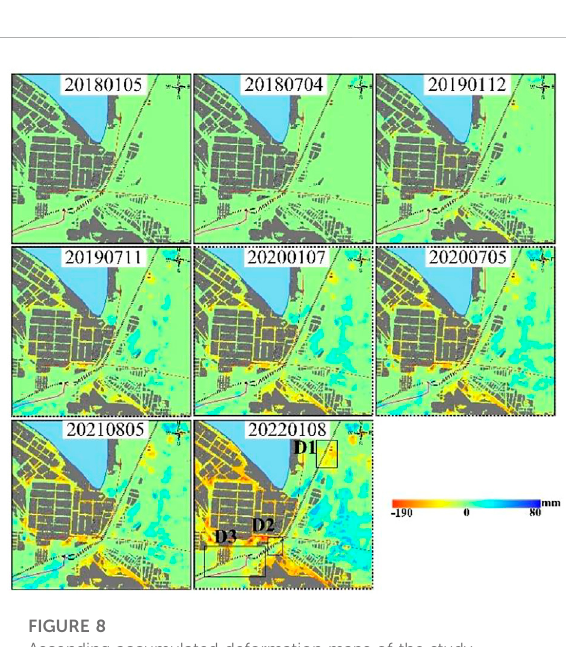
FIGURE 8 Ascending accumulated deformation maps of the study segments along the QGE biannually. The red and yellow fl ags indicate the DRS and QBS. The red lines denote the faults in this